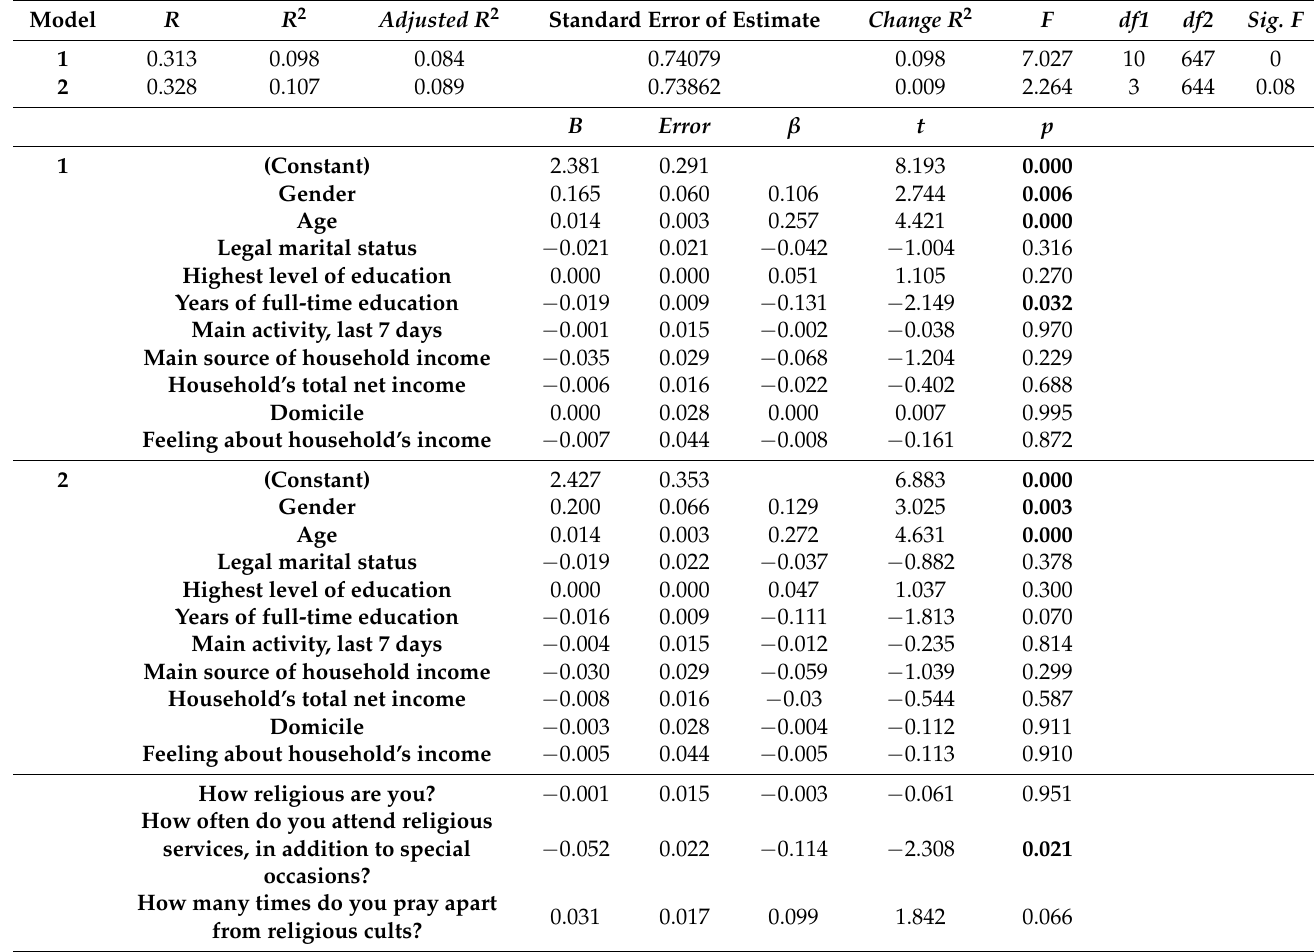
Table 7. Multiple linear regression 1: Contribution to the explanation of the second-order dimension openness to change. Model